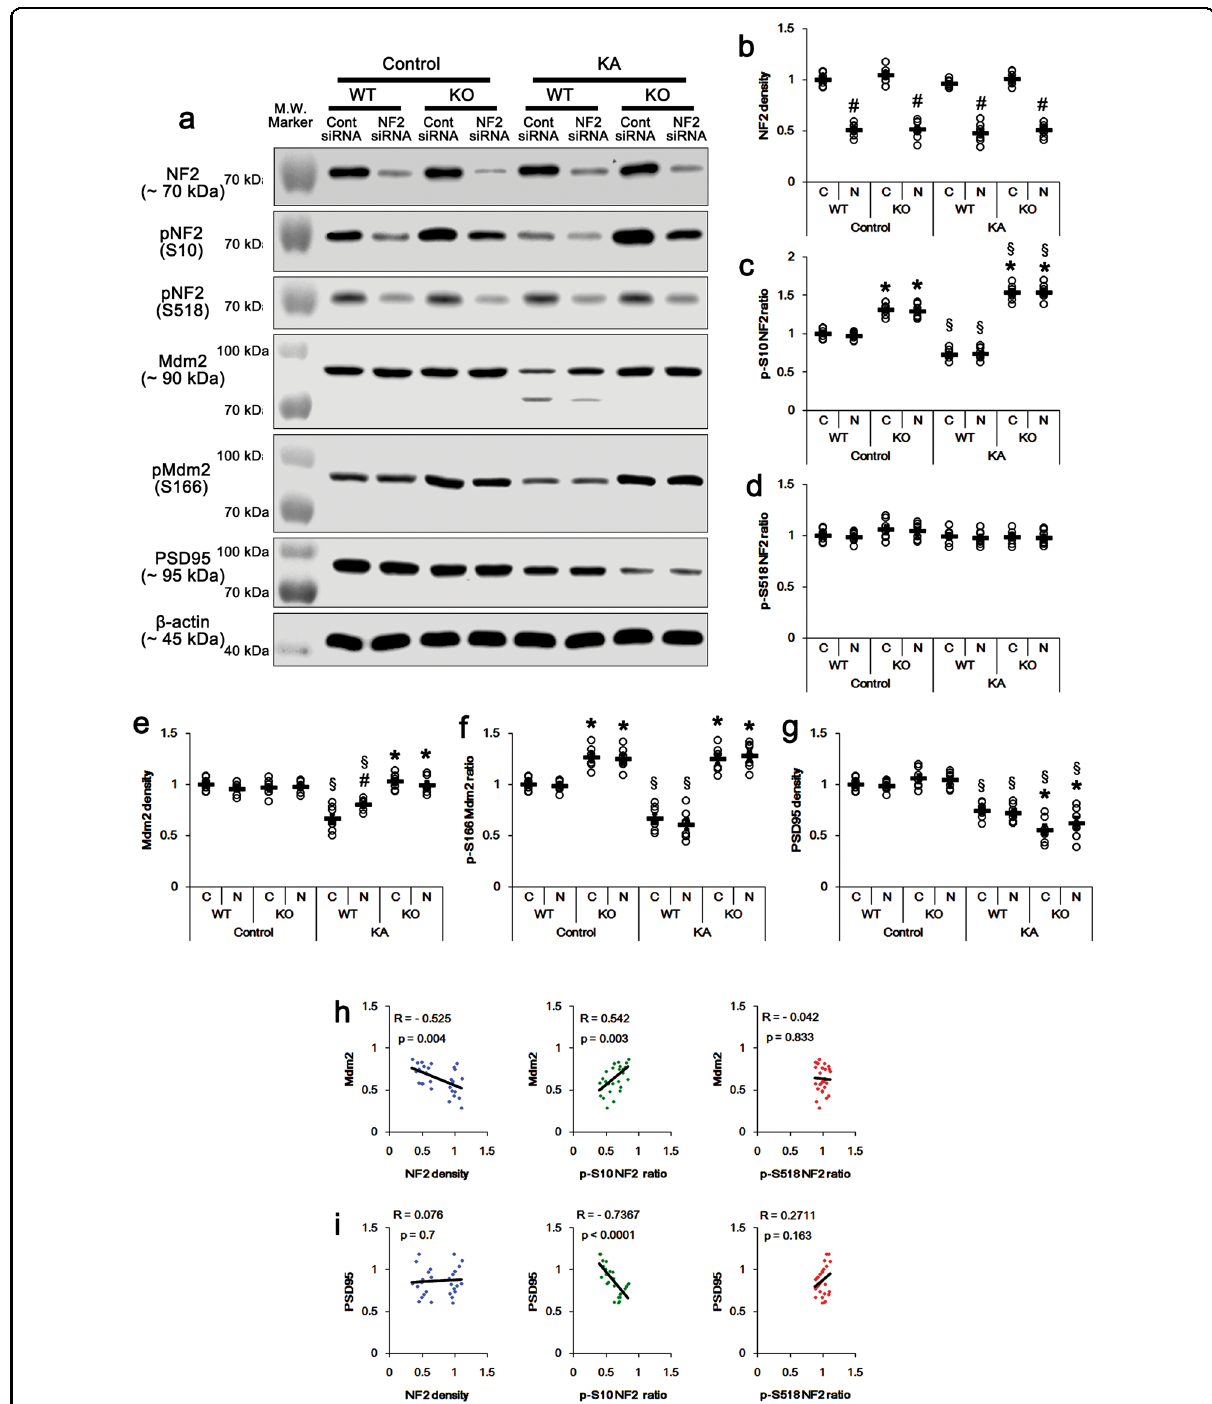
Fig. 7 Effects of NF2 knockdown on protein and phosphorylation levels of NF2, Mdm2, and PSD95 in PLPP/CIN − / − mice following KA injection, and linear regression analysis between NF2 and Mdm2/PSD95 levels. a Representative western blots of NF2, pNF2-S10, pNF2-S518, Mdm2, pMdm2-S166, and PSD95. b – g Quanti fi cation of NF2, pNF2-S10, pNF2-S518, Mdm2, pMdm2-S166, and PSD95 levels based on western blot data. Open circles indicate each individual value. Horizontal bars indicate mean value (* ,#,$ p < 0.05 vs. WT, control siRNA- and control (non-KA-treated) animals, respectively; n = 7). h, i Linear regression analysis between NF2 and Mdm2/PSD95 levels within control siRNA- and NF2 siRNA-treated groups of WT and PLPP/CIN Tg mice following KA